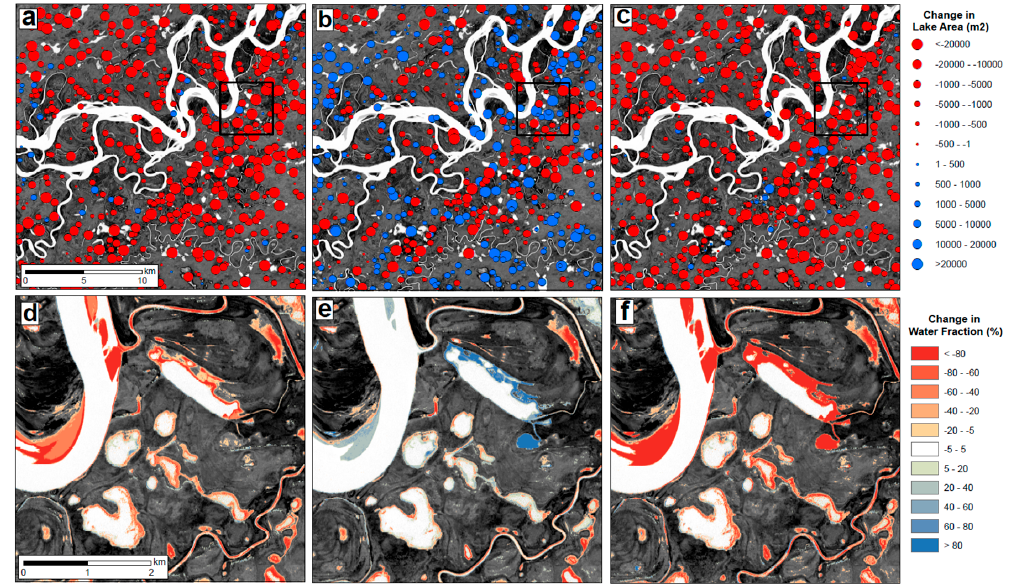
Figure 7. Changes in lake surface areas between (column 1, ( a , d )) 23 June and 1 October, (column 2, ( b , e )) 23 June and 17 August and (column 3, ( c , f )) 17 August and 1 October. In the top row individual water bodies are represented as circles with the sizes of the circles scaled by the area of the change. Bottom row shows the pixel-based change in water fraction. Location of inset shown in top row. Red represents water loss, blue represents water gain.